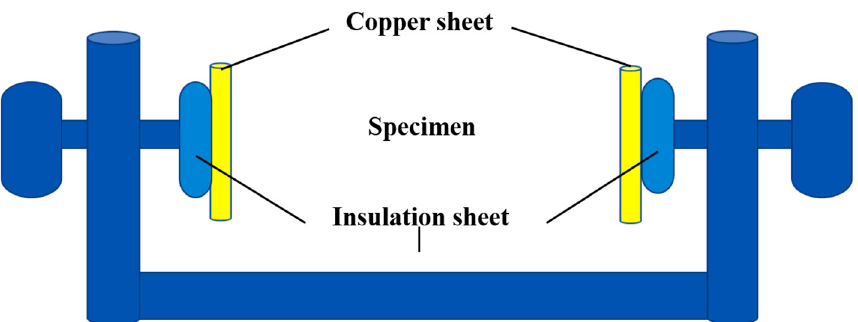
Figure 2. Schematic diagram of resistivity test.